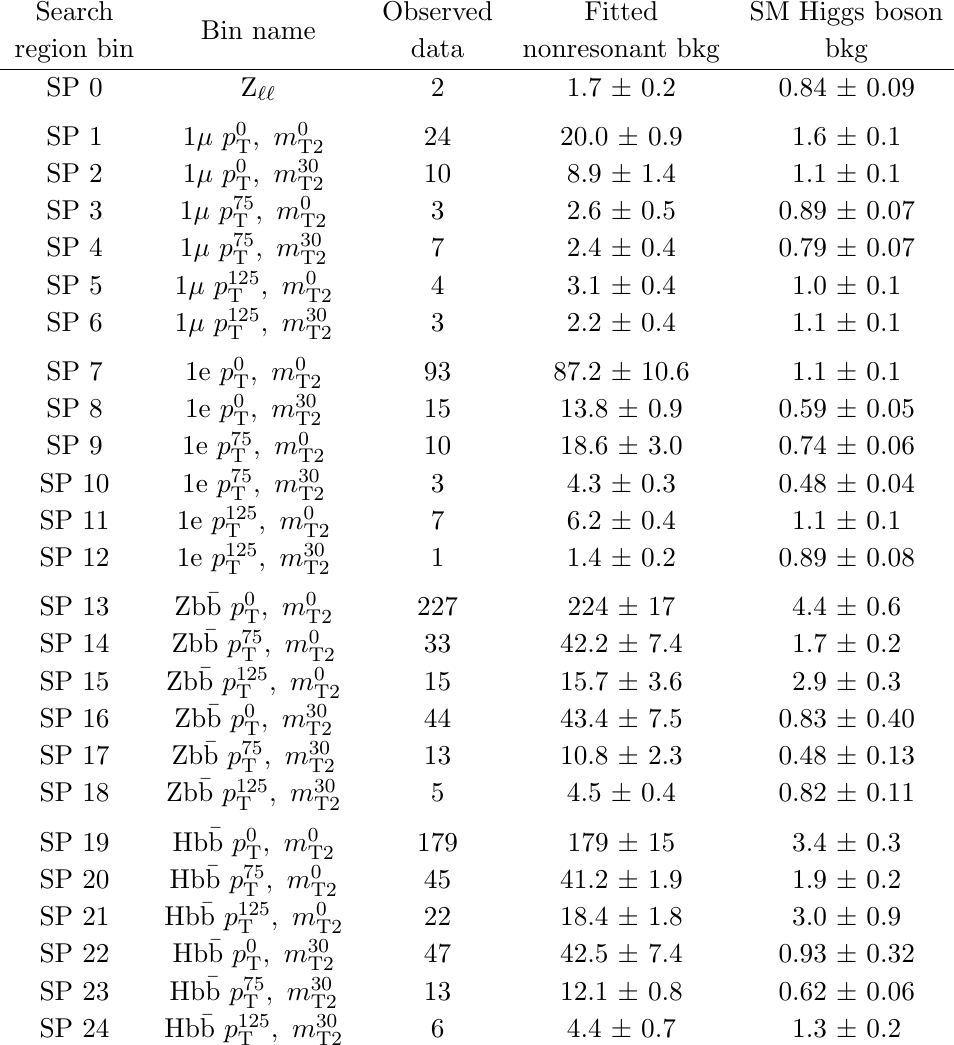
Table 5 . The observed data, (cid:12)tted nonresonant background yields, and SM Higgs boson back- ground yields within the mass window between 122 and 129 GeV are shown for each search region bin in the Hb(cid:22)b, Zb(cid:22)b, and leptonic categories of the SP analysis. The uncertainties quoted are the (cid:12)t uncertainties, which include the impact of all systematic uncertainties. The bin names give a short-form description of the search region bin de(cid:12)nition which are given in full in table 2. The labels p 0 , p 75 , and p 125 T T